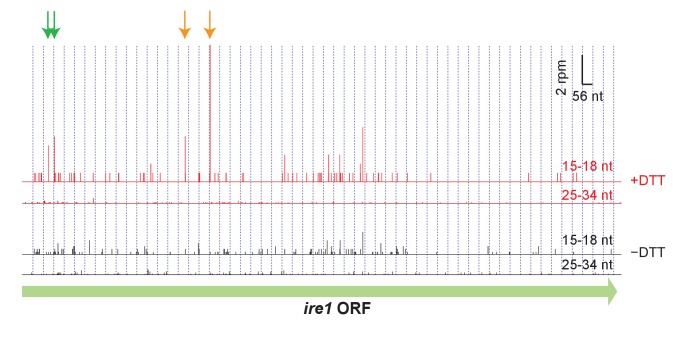
Footprint data (3’ end assignment) from the dom34Δ/ski2Δ strain on the gene ire1.Detected cleavage sites (arrows) are indicated at UG/C motifs (orange) and non-UG/C motifs (green). The presence of cleavage sites is consistent with Ire1 degrading its own transcript.